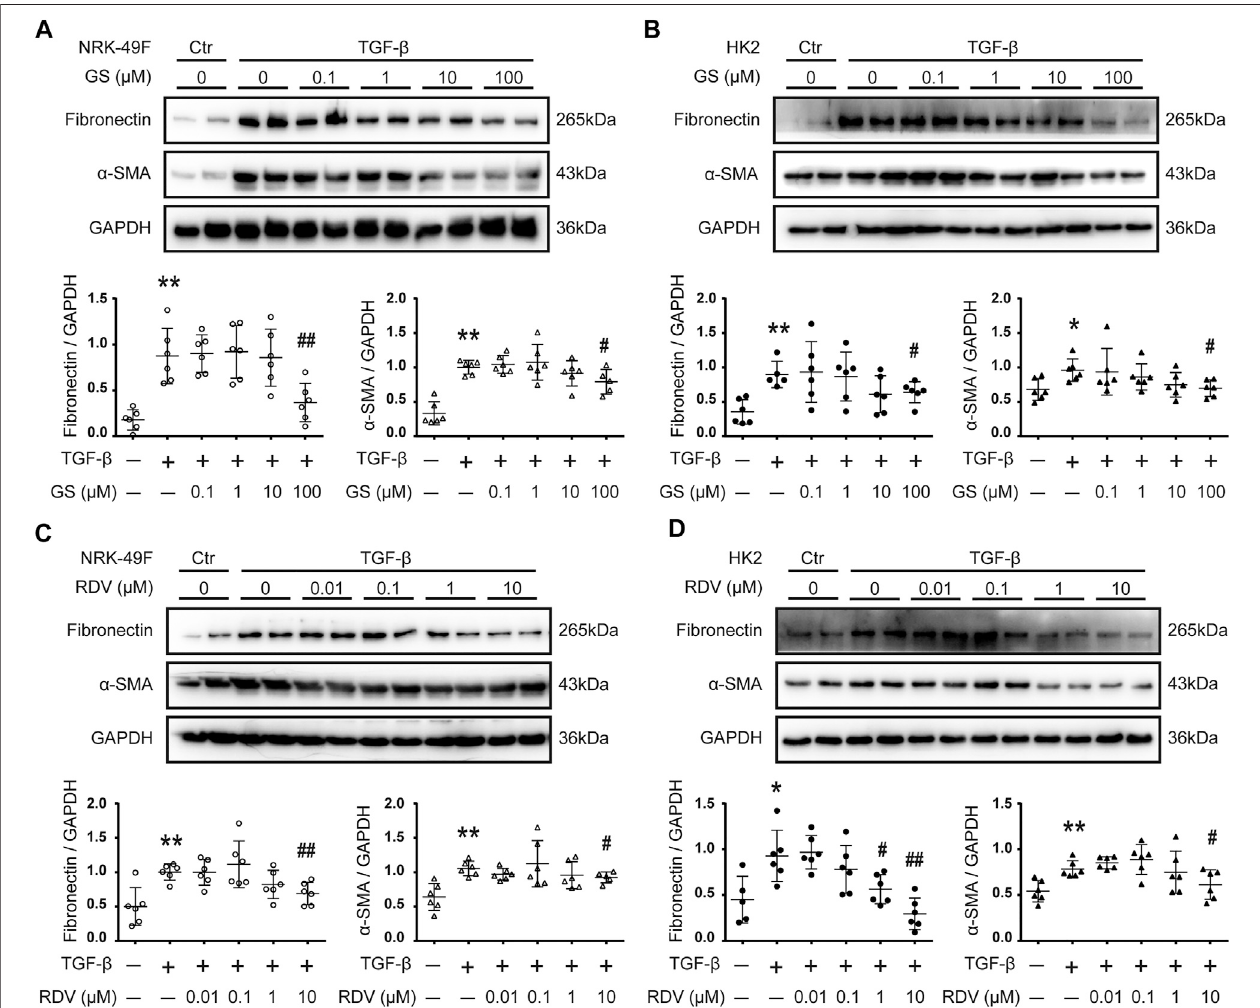
FIGURE 1 | Remdesivir and its intermediate metabolite GS-441524 inhibited renal fi brosis in vitro (A) Following TGF- β stimulation, NRK-49F rat renal fi broblasts cells were treated with various concentration (0, 0.1, 1, 10, 100 μ M) of GS-441524 (GS) for 24 h. The expression of fi bronectin (FN) and alpha-smooth muscle actin ( α -SMA) in NRK-49F cells were analyzed by Western blotting and quanti fi ed (B) Upon TGF- β stimulation, HK2 human renal epithelial cells were treated with various concentration (0, 0.1, 1, 10, 100 μ M) of GS for 48 h. The expression of FN and α -SMA in HK2 cells were analyzed by Western blotting and quanti fi ed (C) TGF- β stimulated NRK-49F cells were treated with various concentration (0, 0.01, 0.1, 1, 10 μ M) of Remdesivir (RDV) for 24 h. The expression of FN and α -SMA in NRK-49F cells were analyzed by Western blotting and quanti fi ed (D) TGF- β stimulated HK2 cells were treated with various concentration (0, 0.01, 0.1, 1, 10 μ M) of RDV for 48 h. The expression ofFN and α -SMAinHK2 cells were analyzed byWestern blottingand quanti fi ed. Datarepresentmean ± SD. * p < 0.05 vs. Vehicle-DMSO; ** p < 0.01vs. Vehicle-DMSO; # p < 0.05 vs. TGF- β -DMSO; ## p < 0.01 vs. TGF- β -DMSO. One representative result of at least three independent experiments is shown.